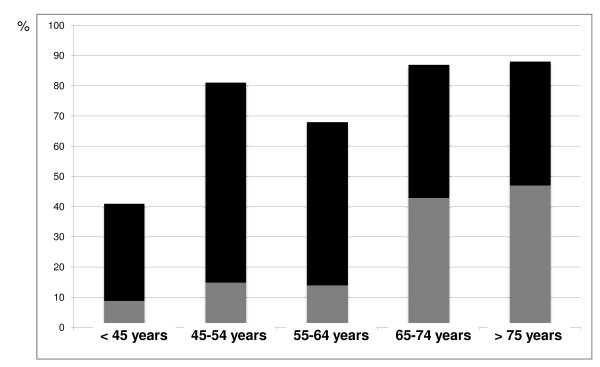
Incidence of documented coronary heart disease according to age and before (gray) and after (black) coronary angiography.